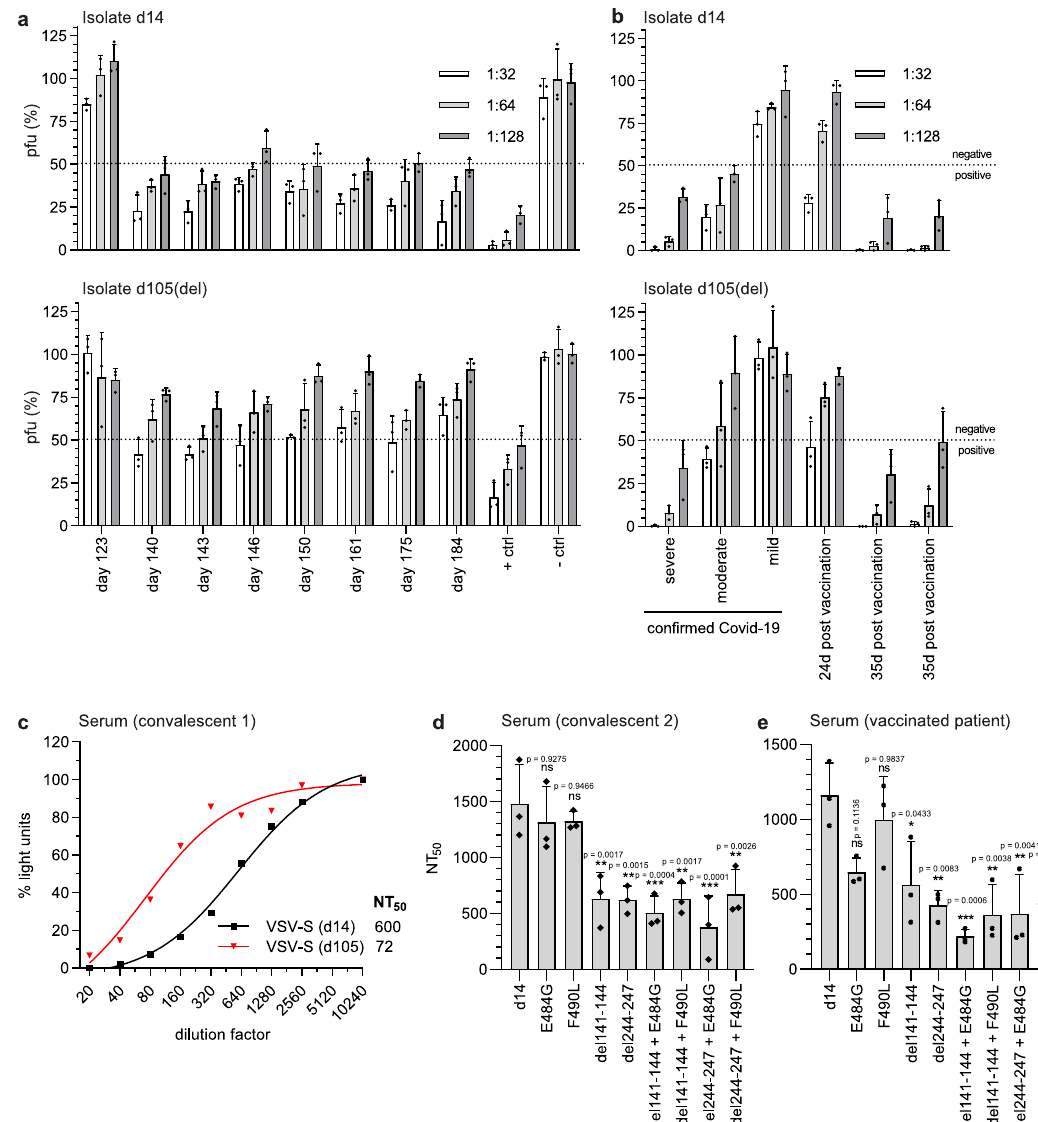
Fig. 5 Delayed seroconversion and viral escape from the spike protein-speci fi c antibody response. a , b Detection of neutralizing activity of immune sera against SARS-CoV-2 variants. 100 pfu of the d14 and d105(del) isolates were incubated for 60 min at room temperature with serial dilutions of the patient sera. Sera obtained from naïve ( – ctrl) or convalescent individuals ( + ctrl) served as negative and positive controls. Virus neutralization was determined by plaque assay on VeroE6 cells. Virus titers are indicated as percentages (mean ± SD) of the titer of the untreated virus inoculum. The dotted lines indicate the cutoff value between positive (<50%) and negative (>50%) neutralization. Shown are the means of three biological replicates. a Sera from the immunocompromised patient. The times of blood withdrawal are indicated. b Convalescent sera from COVID-19 patients suffering from mild, moderate, or severe disease or human post-vaccination (BNT162b2 mRNA) sera. c – e Neutralization capacity of SARS-CoV-2 antisera using VSV* Δ G(FLuc) vector pseudotyped with the SARS-CoV-2 spike protein and coding for fi re fl y luciferase. The pseudotyped viruses were incubated with serial dilutions of a COVID-19 convalescent serum prior to inoculation of VeroE6 cells. Pseudotyped virus infection was monitored 16 h post-infection by measuring the fi re fl y luciferase activity in the cell lysates. The control without serum was set to 100%. c Neutralization of VSV* Δ G(FLuc) pseudotyped with the early and late SARS-CoV-2 spike variants (d14 and d105). d , e Neutralization of VSV* Δ G(FLuc) pseudotyped with the d14 spike protein containing the individual or combined mutations found in the late d105 and d140 sequences. Immune sera from two different convalescent COVID-19 patients ( c , d ) or a vaccinated person ( e ) were analyzed. The neutralization was determined by calculating the NT 50 via a non-linear regression (variable slope, four parameters). Shown are means ± SD ( n = 3). Statistics were calculated with a one-way ANOVA (Tukey ’ s multiple comparison test), ns = non-signi fi cant, * p < 0.05, ** p < 0.01, *** p < 0.001. The exact p -values are given in the fi gure. Source data are provided as a Source Data fi